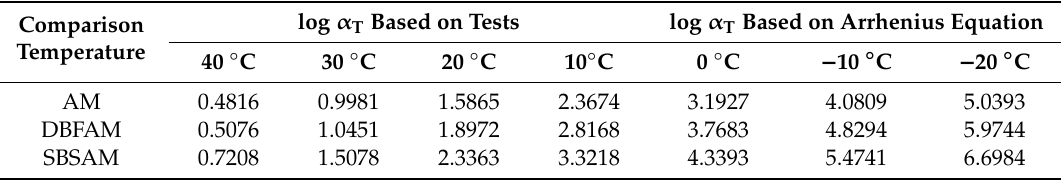
Figure 2. Creep compliances at different temperatures: ( a ) asphalt mixture (AM); ( b ) diatomite and basalt fibers reinforced asphalt mixture (DBFAM); ( c ) styrene-butadiene-styrene modified asphalt mixture (SBSAM). Table 5. The shift factors at 50 ℃ reference temperature.